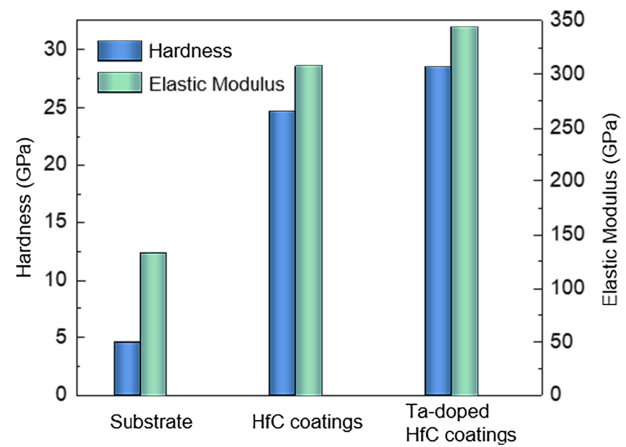
Figure 8. Experimental elastic properties and hardness of coatings and substrate.